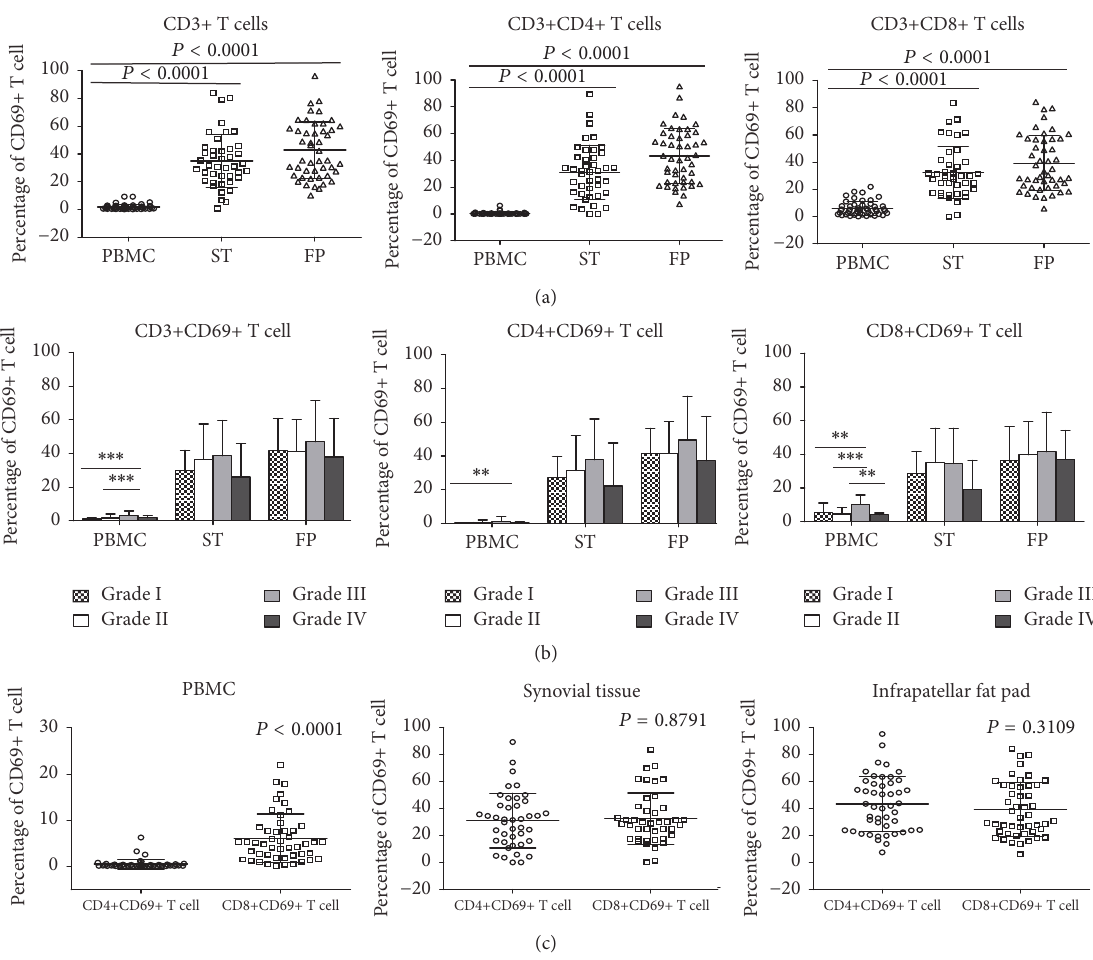
Figure 3: Activation phenotype of T cells isolated from peripheral blood, synovial tissue, and infrapatellar fat pad of knee osteoarthritis patients. Mononuclear cells were isolated from peripheral blood, synovial tissue, and infrapatellar far pad labeled for CD69 surface expression. (a) Graphs showing total T cell and T cell subset (CD4+ and CD8+) frequencies in peripheral blood (PBMC) ( 𝑁 = 48 ), synovial tissue ( 𝑁 = 42 ), and infrapatellar fat pad ( 𝑁 = 47 ). Mean values are shown with error bars. (b) Bar graphs showing the mean frequency of CD69+ totalTcellsandCD69+Tcellsubsets(CD4+andCD8+)stratifiedbasedontheAhlbackclassificationforradiographicgrading.Barsrepresent mean values with error bars. (c) Comparison of frequency of CD4+CD69+ and CD8+CD69+ T cells in peripheral blood, synovial tissue, and infrapatellar fat pad. Shown are mean values. 𝑃 < 0.05 was considered significant. ( ∗∗∗ 𝑝 < 0.0001 ; ∗∗ 𝑝 < 0.005 ; ∗ 𝑝 < 0.01